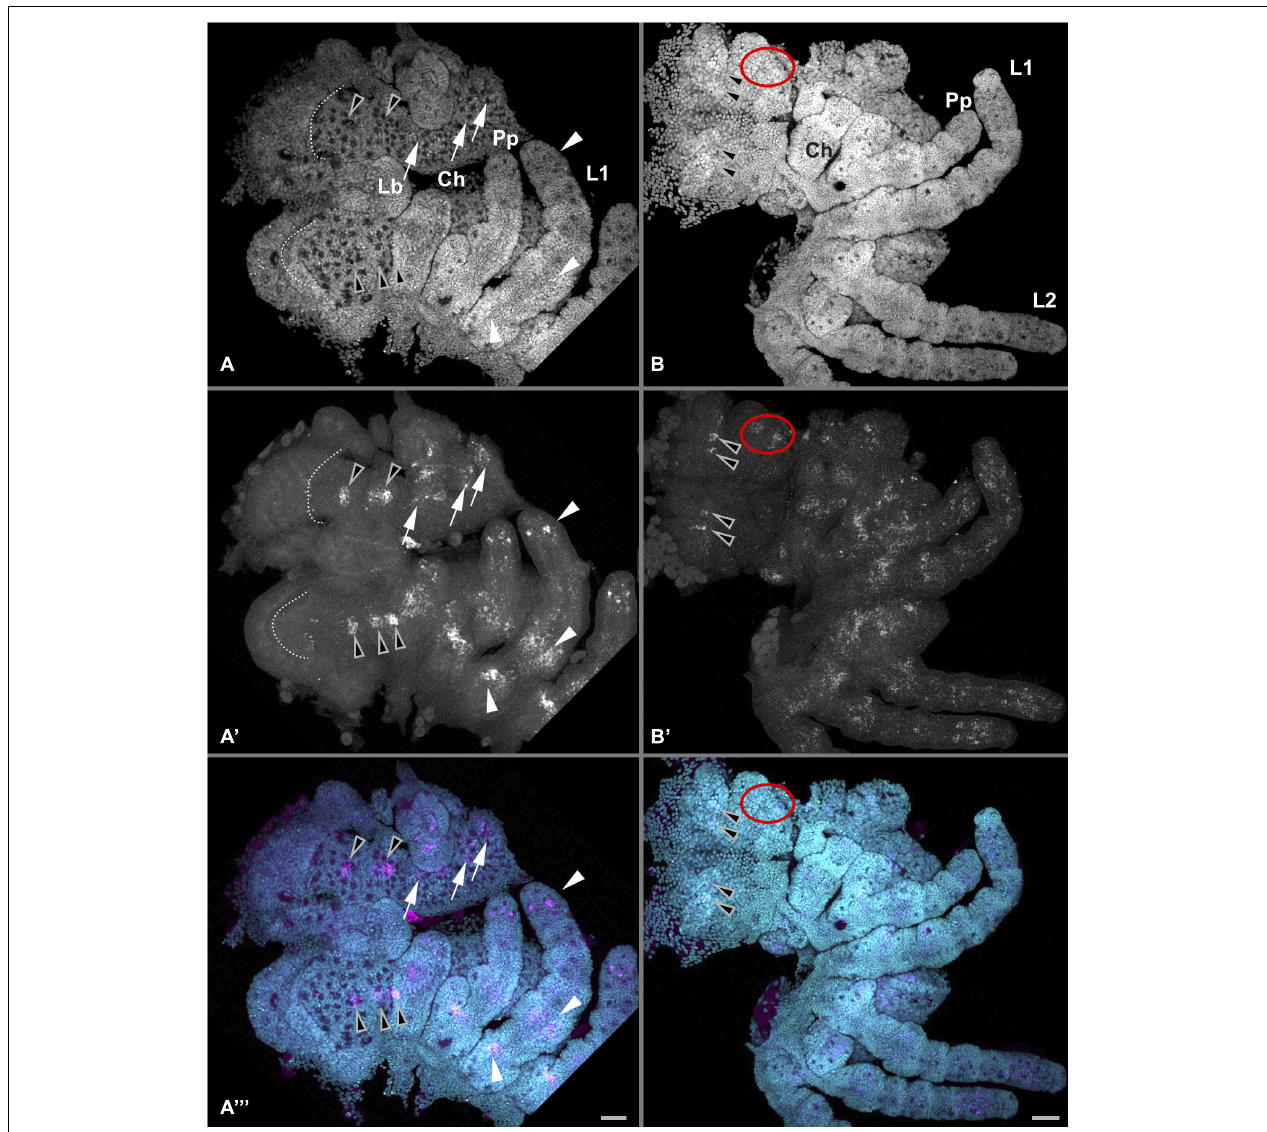
FIGURE 6 | Detailed Pt-Pax2.2 expression in the anterior embryo. Anterior is to the left in all panels. Left panels (A–A”) show Pt-Pax2.2 expression during late retraction of the embryo (Stage 12) in the ventral neuroectoderm (white arrows), the appendages (arrowheads), and in the brain (black arrowheads). During this stage the dynamic expression in the neurogenic part of the head lobes later giving rise to the brain is detectable. While in one half of the head only two expression domains are visible in the other half already three distinct expression domains are present. Pt-Pax2.2 expression in the pedipalps and walking legs is present in one proximal and one medial domain as well as in a spot-like pattern in the distal tip. Dotted line indicates anterior furrow in the head lobes. Right panels (B–B”) show Pt-Pax2.2 expression later in embryos during ventral closure (Stage 14), present as two spots in the brain (black arrowheads), as well as in two clusters at the lateral rim of the head (red ellipses). Expression in the prosomal appendages is still present but more diffuse. Lb, labrum. Prosomal appendages: Ch, chelicerae; Pp, pedipalps; L1, 1st walking leg. Cyan is nuclear DAPI staining; magenta is Pt-Pax2.2 specific expression detected with FAST RED. Scale bar represents 50 µ